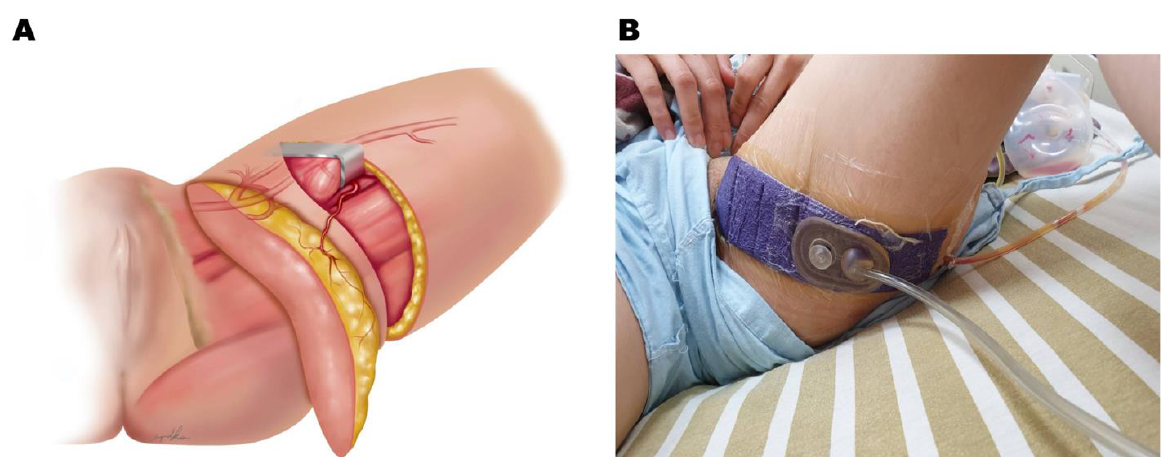
Figure 1. Flap design and clinical application of iNPWT. ( A ) A sketch illustrates how the flap is designed and harvested. ( B ) Postoperative application of closed-incision negative pressure on the donor site of a PAP free flap harvested in the transverse